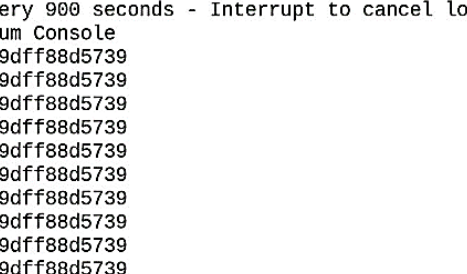
Figure 21. Node-Red: STRESQLab Smart Metering Server.